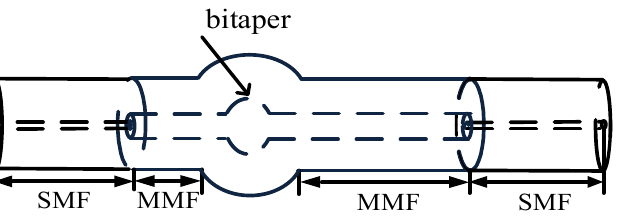
Figure 3. Schematic diagram of the SMBMS MZI with the position of the bitaper set to one third of the sensing arm.